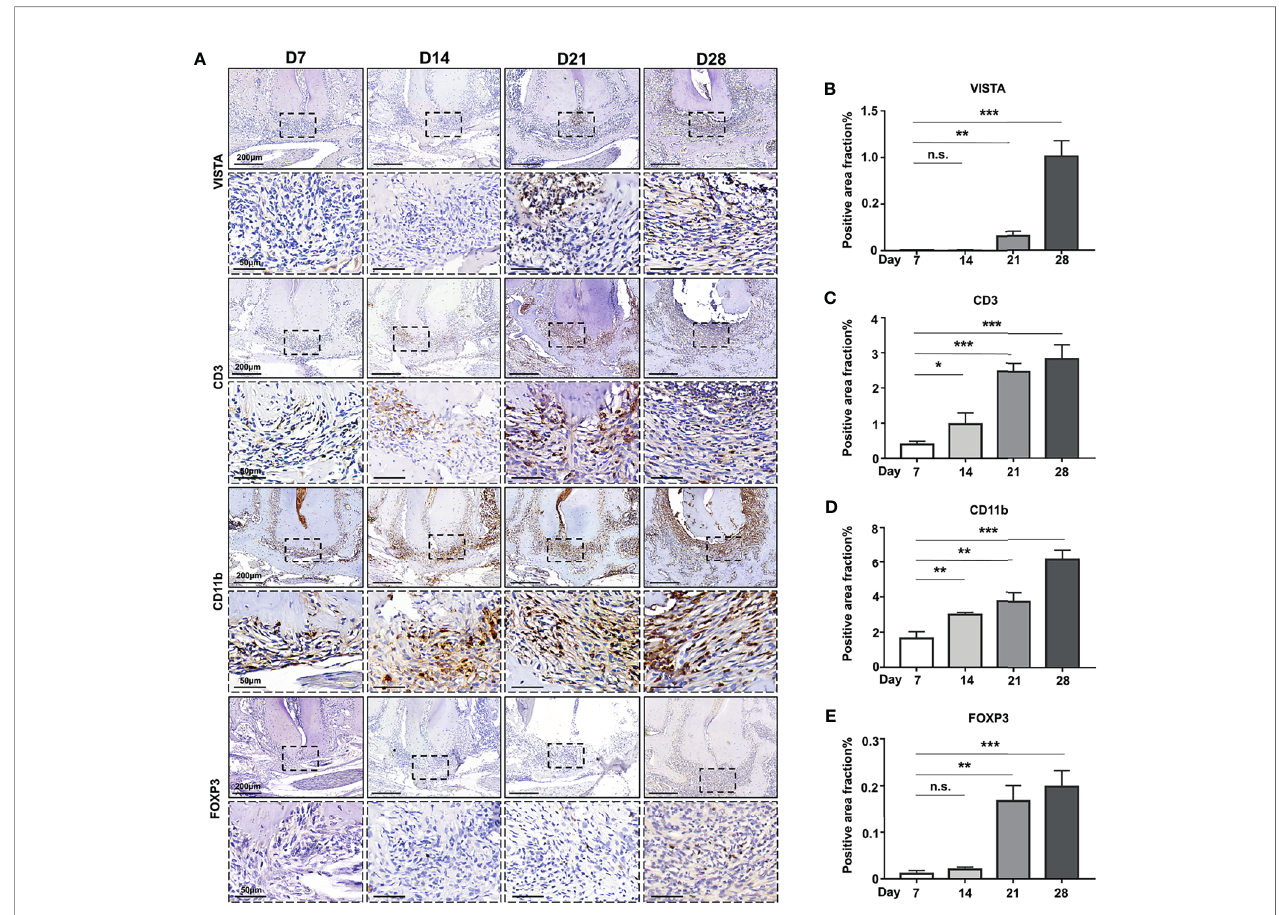
FIGURE 2 | The expression of VISTA and immune cell in fi ltration in mouse experimental apical periodontitis. (A) The accumulation of CD3-, FOXP3-, CD11b-, and VISTA-positive cells at different time points in mouse experimental apical periodontitis tissues 7 days, 14 days, 21 days and 28 days after the mice underwent the pulp exposure procedure (n=5). Quantitative analysis of (B) VISTA-, (C) CD3-, (D) CD11b-, and (E) FOXP3-positive cells. Scale bars=200 m m or 50 m m at different magni fi cations, as shown in the images. n.s., not signi fi cant. *p < 0.05, **p < 0.01, ***p <